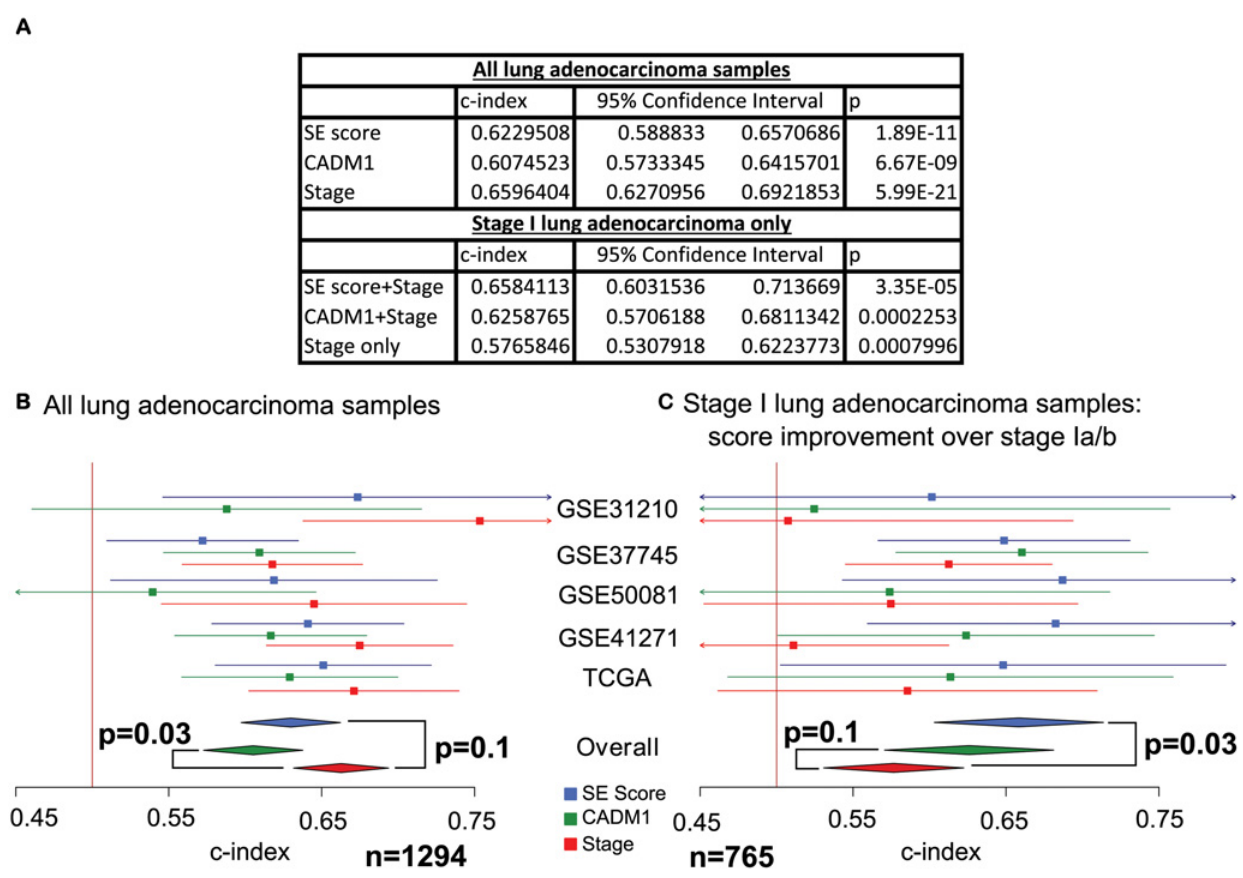
Fig 5. Meta-analysis comparison of the lung cancer SE score with the expression of CADM1 . A) Survival analysis statistics for the SE score and CADM1 expression over all samples and stage I samples, statistics across stage I samples are provided for the 2 scores combined with stage Ia/b status, c- index denotes concordance index and p denotes p -value. B) The plots display the concordance index for the SE score, CADM1 expression and pathological tumour stage in each data set alongside 95% confidence intervals. The overall concordance indices were derived and compared via meta-analysis using a random effects model. The vertical line denotes concordance index = 0.5, data sets where the confidence interval for the concordance index crosses this line did not reach significance. Meta-analysis across 5 validation data sets reveals that the SE score performs comparably to tumour stage, whilst CADM1 expression is outperformed by tumour stage. (C) The plots display the concordance index for the SE score and CADM1 expression combined with stage Ia/b status, as well as stage Ia/b status alone, for stage I samples in each data set alongside 95% confidence intervals. Meta-analysis across 5 validation data sets reveals that only the SE score adds prognostic value to stage Ia/b